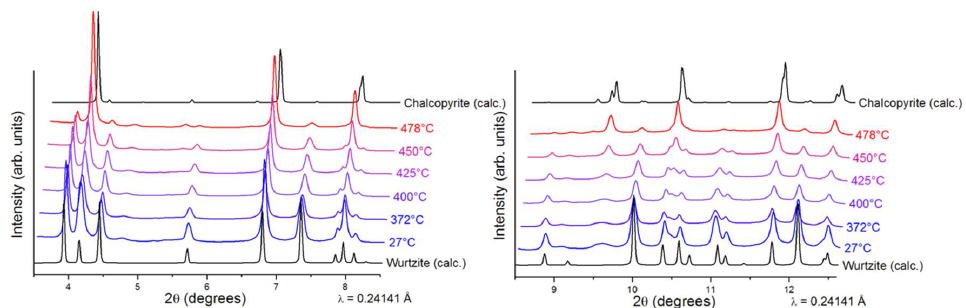
Figure 3. In-situ variable temperature synchrotron powder XRD of wurtzite CuInSe 2 (CIS) NPs sample (λ = 0.24141 Å). The sample was heated from room temperature (bottom pattern) to 478 °C (top pattern).